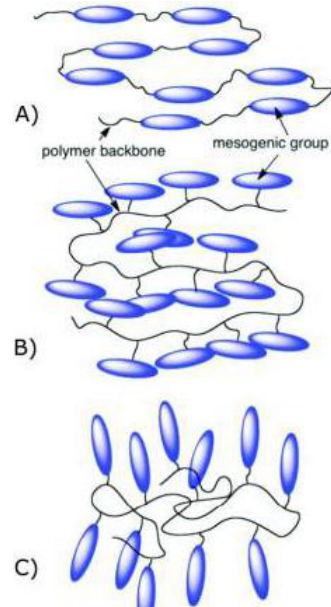
Figure 2. Scheme representation of examples of side-chain and main chain elastomers ( A ) end-on main chain; ( B ) side-on side-chain; and ( C ) end-on side-chain liquid crystal elastomers (LCEs). Reprinted with permission from Reference [11], Copyright 2017 ACS Books.